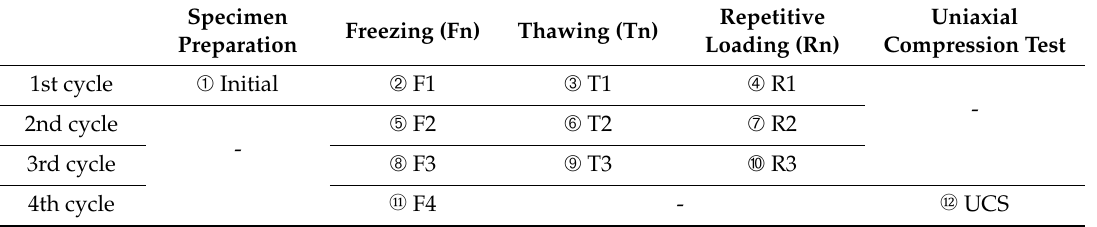
Table 1. Test procedure with abbreviations.